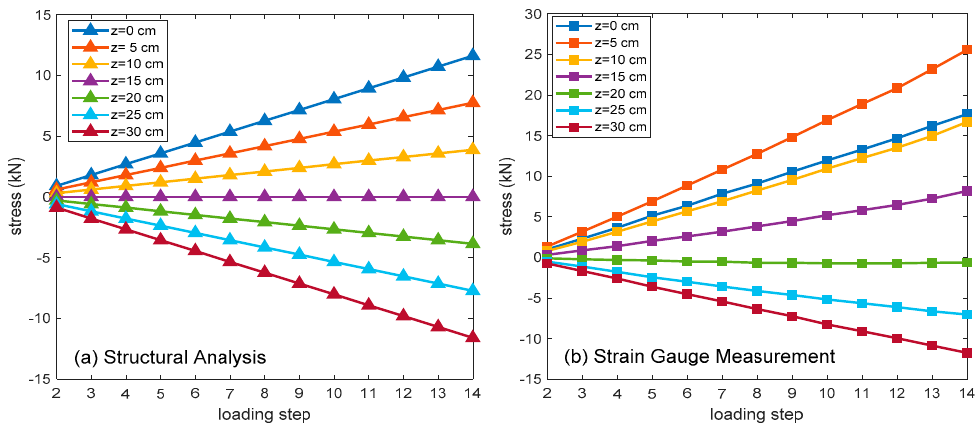
Figure 5. The analysis and measurement stress changing values along the section of L/2.